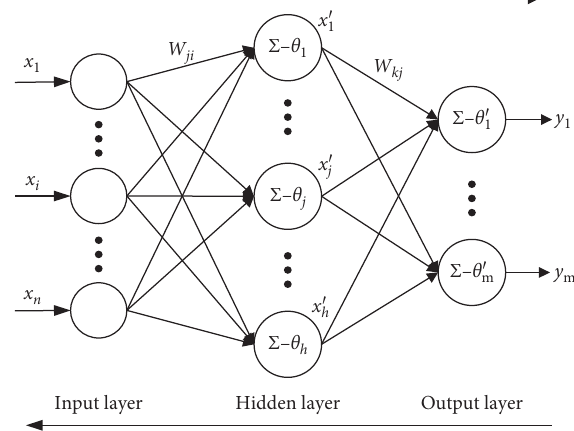
Figure 1: Research content flow chart.